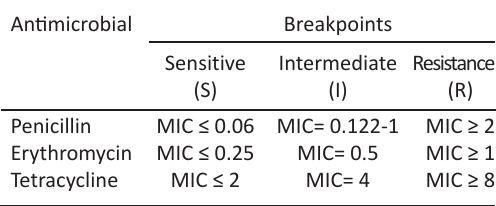
guidelines of the Clinical and Laboratory Standard Institute 6